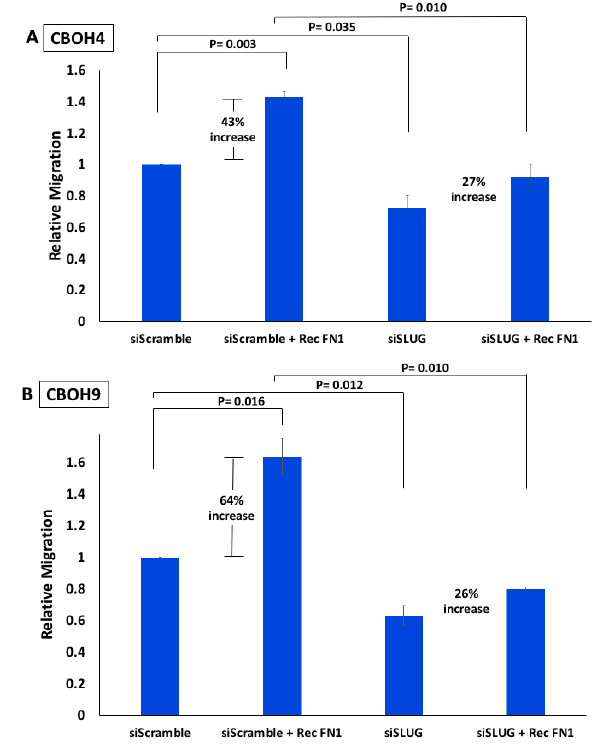
Figure 5. Recombinant FN1 is enough to induce greater migration in CTCs but not sufficient to completely rescue deficits in migration when SLUG is knocked down. Recombinant FN1 was added to CTCs that were treated concurrently with either siScramble or siSLUG. Migration was then assessed via wound healing assays performed on ( A ) CBOH4 and ( B ) CBOH9. Data are presented as mean ± standard error of the mean (SEM); n = 3. Statistical analysis was performed using t -test, where p < 0.05 was deemed significant.